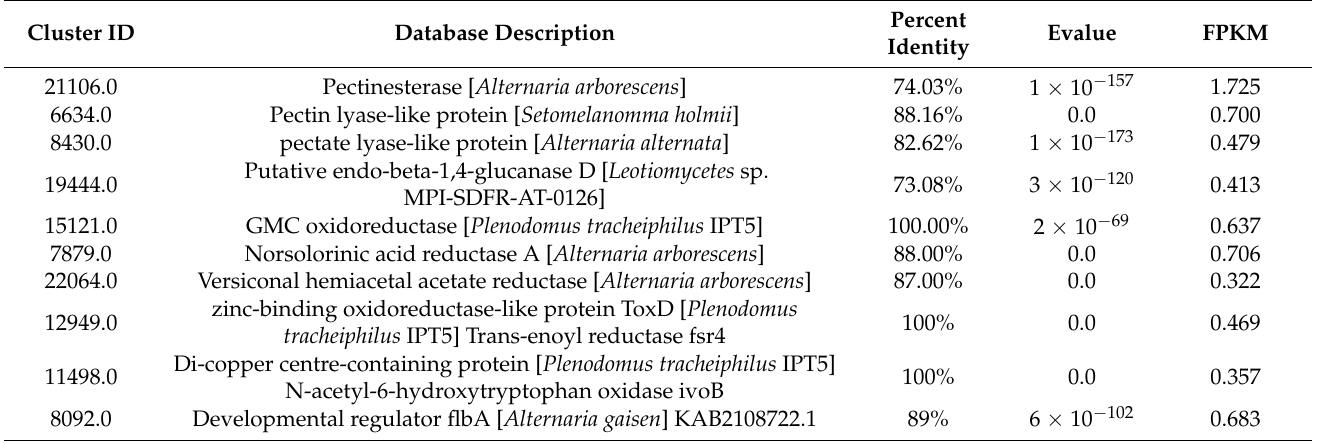
Table 2. Non-outlier fungus transcripts expressed during rough lemon